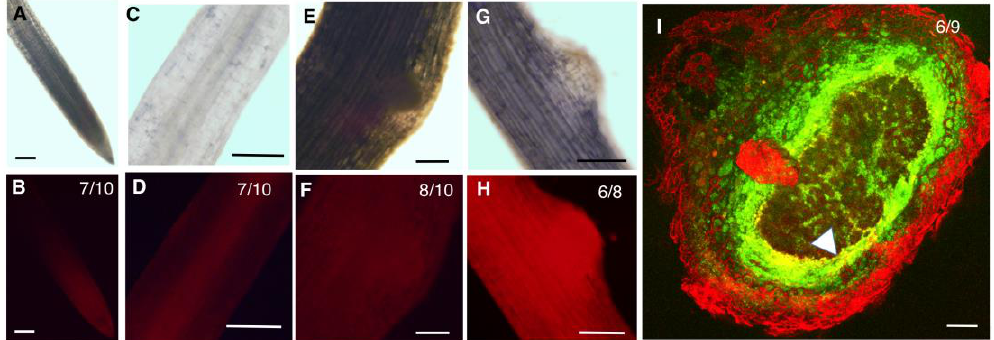
Figure 3. Spatio-temporal expression patterns of GmHD-ZIPIII-1. Expression of GmHD-ZIP III-1p:TdTomato in whole mounts of a soybean root tip ( A and B ), mature root region showing the root stele ( C and D ), an emerging lateral root ( E and F ), and an emerging nodule ( G and H ), imaged using a compound fluorescence microscope. A , C , E and G are bright field images and B , D , F , and H are corresponding fluorescence images obtained using a Propidium Iodide/tetramethylrhodamine isothiocyanate (PI/TRITC) filter. ( I ) A median section of a mature nodule longitudinal to the nodule axis showing expression of GmHD-ZIPIII-1p:TdTomato in the nodule parenchyma imaged using a laser confocal microscope. Tdtomato (red) signal appears yellow due to overlap with a co-expressed constitutive GFP construct. Bright red fluorescence in the nodule and root peripheries and the root stele indicate non-specific fluorescence. See Figure S4 for split channels and color blind-friendly composite image. Scale bars are 100 μm. The number of independent transgenic roots/nodules showing representative patterns out of the total number evaluated are indicated in panels B , D , F , H and I .